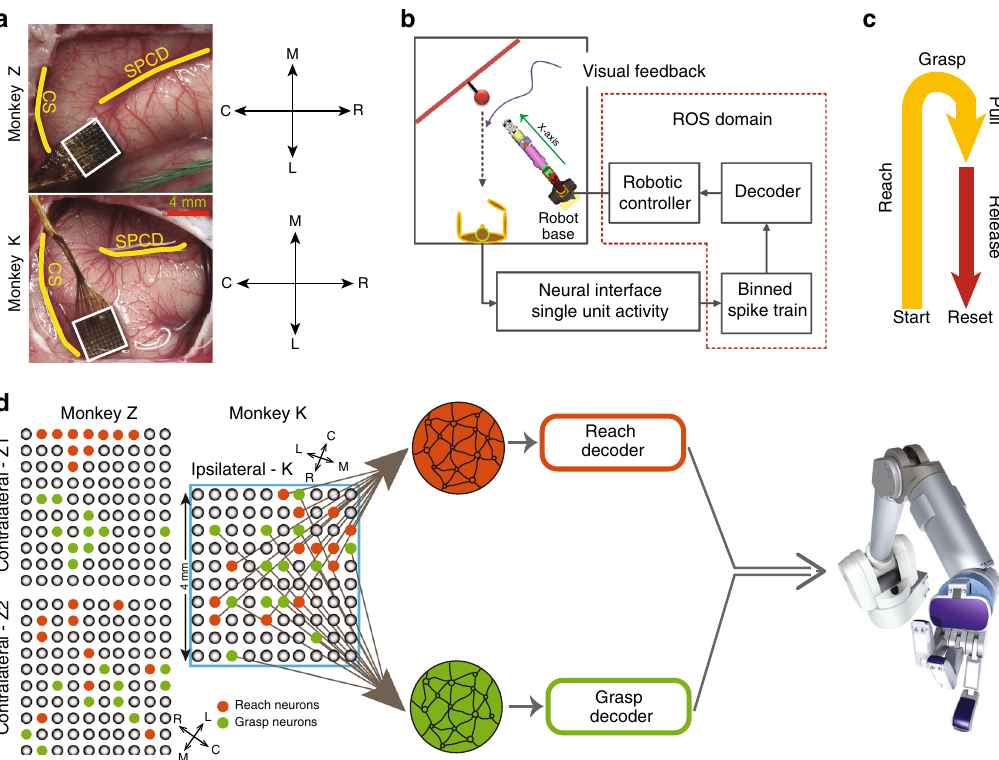
Fig. 6 Schematic of the brain – machine interface and the motor task. a Cortical landmarks and the location of array implantation (SPCD, superior precentral dimple; CS, central sulcus). b Neural spike trains were decoded to generate control signals for the robot. Blocks within the dotted region were implemented in the Robotic Operating System (ROS) platform. c The behavioral task comprises reaching toward an object, grasping and pulling it through a partial trajectory back, and release d two neural subpopulations, reach (red) and grasp (green) were decoded independently to generate control velocities for the robot. Spatial distribution of the clusters are shown for the contralateral and ipsilateral